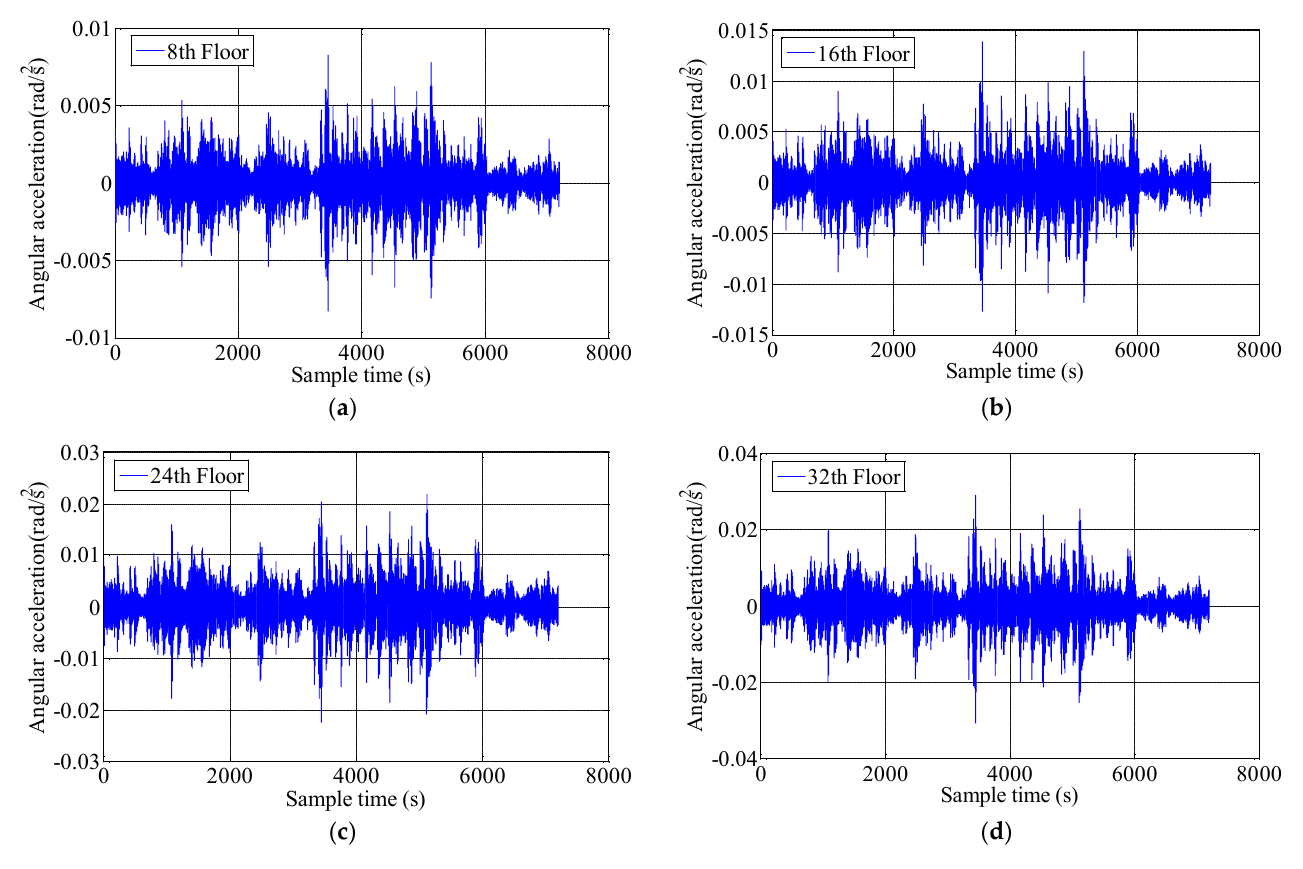
Figure 8. The time-history response of torsional angular accelerations on 8th, 16th, 24th and 32nd floors during Typhoon Sarika. ( a ) 8th floor; ( b ) 16th floor; ( c ) 24th floor; ( d ) 32nd floor.